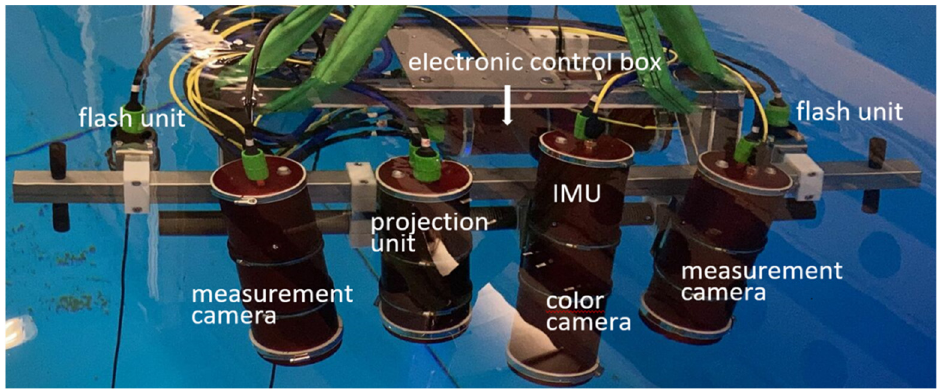
Figure 1. Laboratory setup of